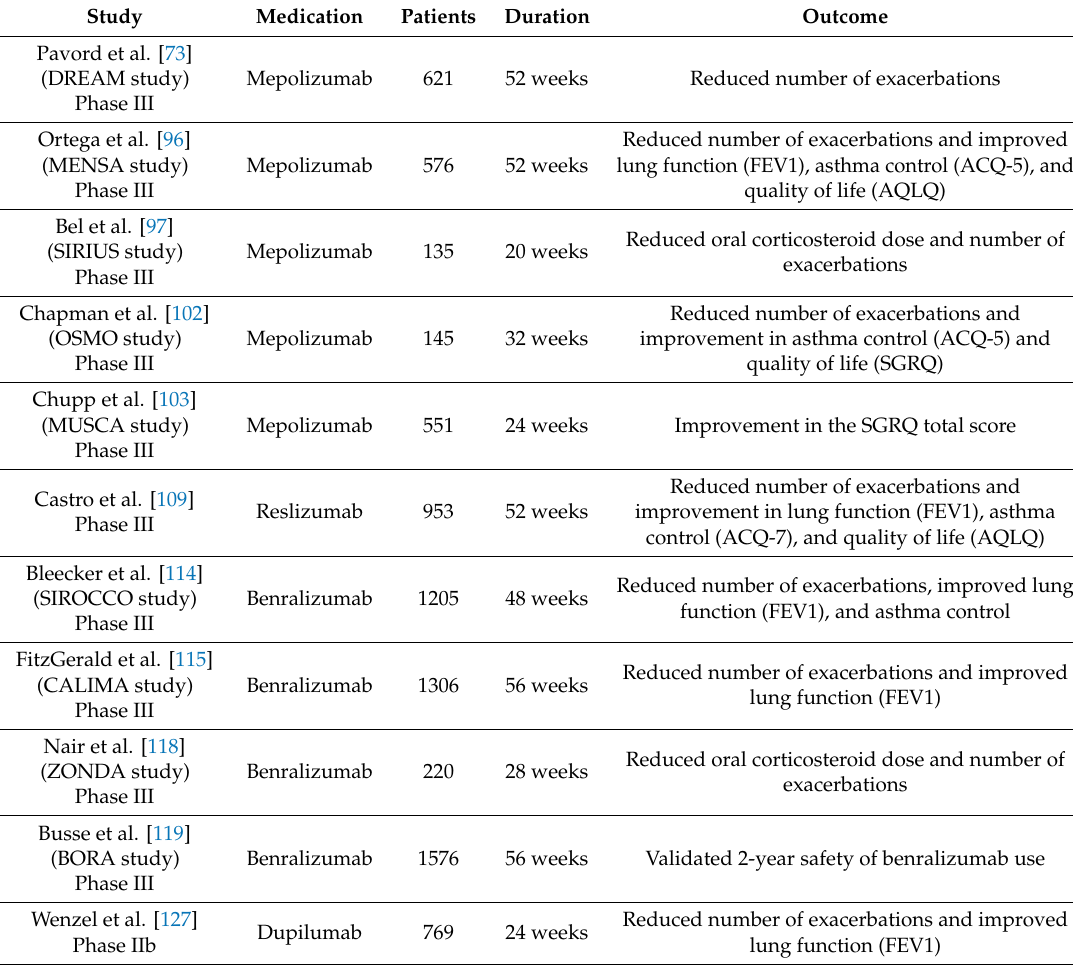
Table 1. Studies on biologic therapies for severe eosinophilic